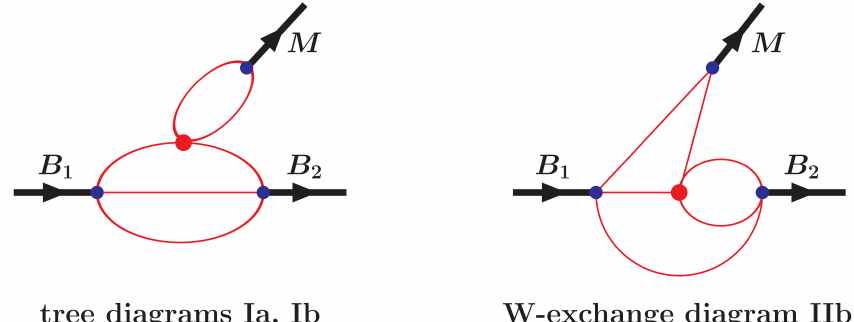
Figure 3. Pictorial representations of Equations (9) and